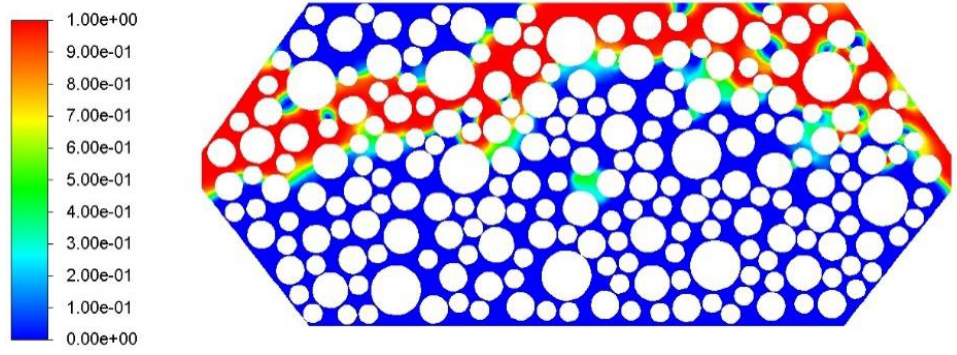
Figure 7. The volume fraction of residual oil (blue) from the simulation after breakthrough.